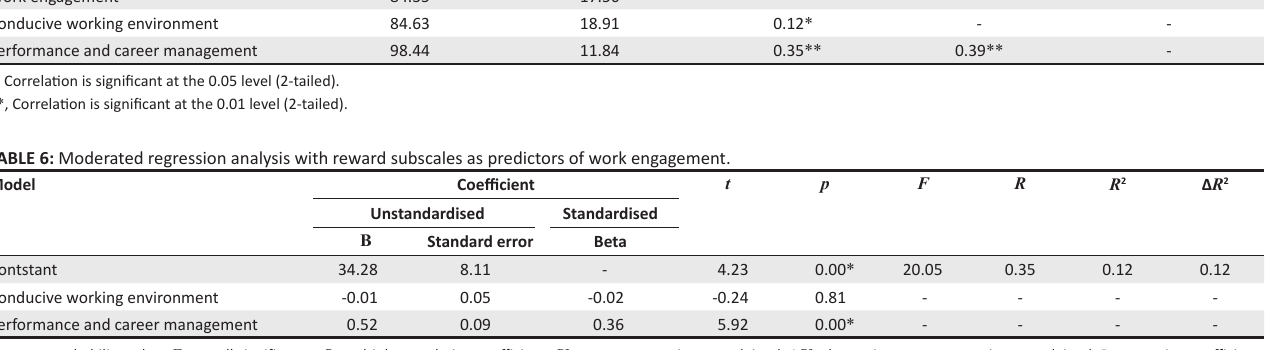
TABLE 5: Correlations between reward subscales and work engagement Subscales